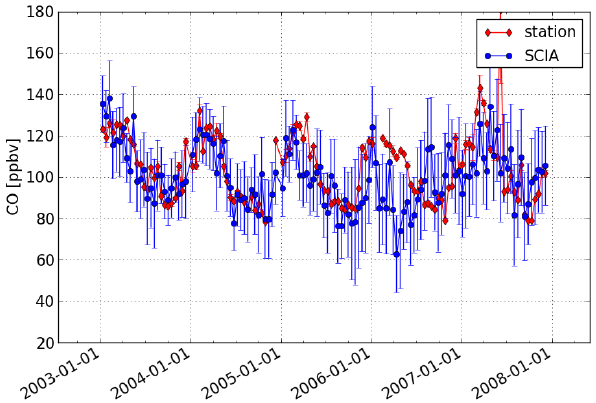
Fig. 20. Intercomparison of SCIAMACHY CO over Central Sa- Fig. 20. SCIAMACHY CO over Central Sahara and intercomparison with Assekrem WDCGG hara with Assekrem WDCGG station (Ahaggar Mountains, 2710m station data (Ahaggar Mountains, 2710m above sea level). Note that the SCIAMACHY CO above sea level) data. Note that the SCIAMACHY CO retrievals are retrievals are dry-air column mixing ratios and the Assekrem WDCGG CO data are volume dry-air column mixing ratios and the Assekrem WDCGG CO data mixing ratios at surface level. The time step is in both cases 14 days. The error bars represent are volume mixing ratios at surface level. The time step is in both the standard deviation of the data. cases 14 days. The error bars represent the standard deviation of the